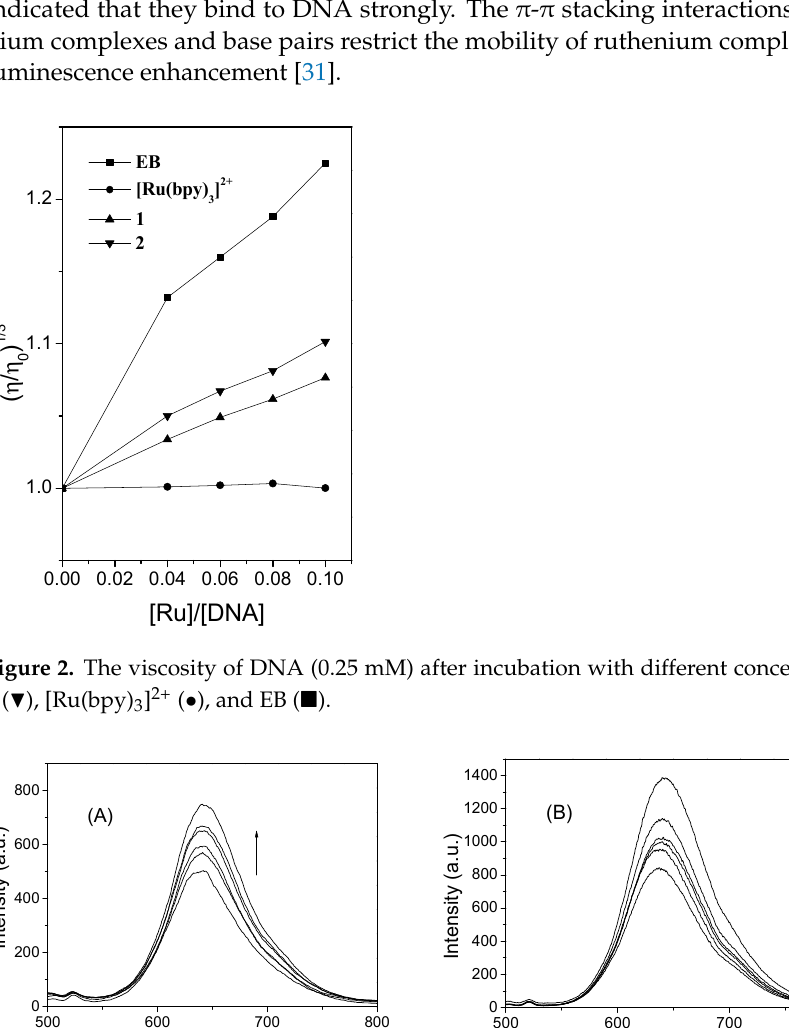
Figure 3. Luminescence spectra of 1 ( A ) and 2 ( B ) (5 µ M) after binding to CT-DNA. To further investigate the strong DNA affinity of two complexes, [Fe(CN) 6 ] 4 − was used to quench the luminescence of the complexes with or without DNA. [Fe(CN) 6 ] 4 − is a tetra-charged anion, which may bind to ruthenium complex cations via electrostatic attraction [32]. Thiswill lead to the decrease in the luminescence of the complexes. Protection of ruthenium complex cation by DNA against [Fe(CN) 6 ] 4 − will prevent luminescence quenching, which depends on the degree of protection by DNA [32]. The emission spectra of two complexes without or with DNA were collected in the range of 500 to 800 nm (Figure 4). In the presence of 0–1 mM [Fe(CN) 6 ] 4 − , the luminescence intensities of the complex solutions decreased sharply. In the presence of DNA, the degree of luminescence quenching obviously decreased, indicating that DNA efficiently protected ruthenium complexes from [Fe(CN) 6 ] 4 − , and strong interactions existed between the two complexes and DNA.